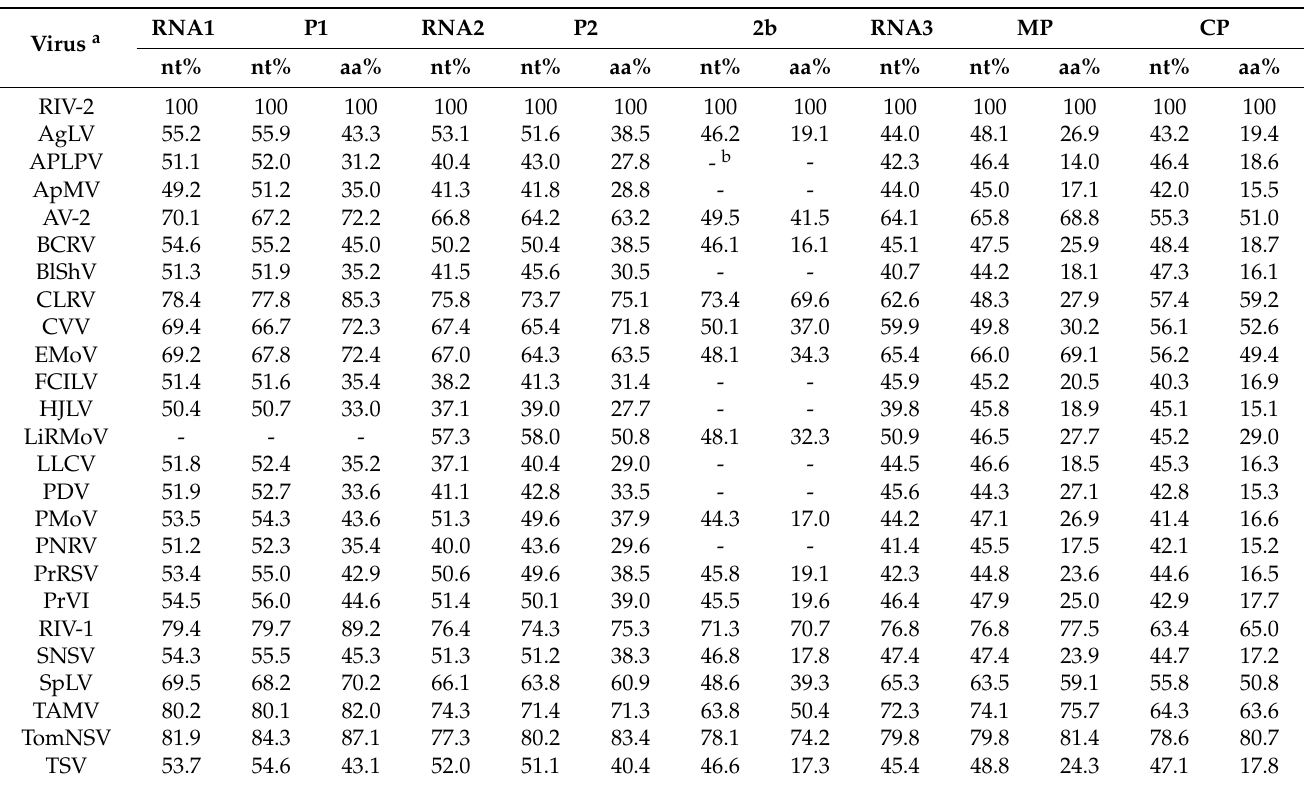
Table 2. Comparison of nucleotide (nt) and amino acid (aa) sequences of the whole genome sequence of rose ilarvirus 2 (RIV-2) with other Ilarvirus